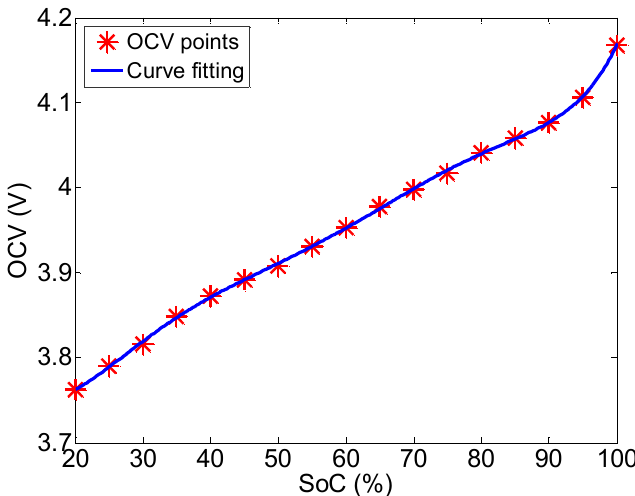
Figure 4. Recorded OCV points and curve fitting results.